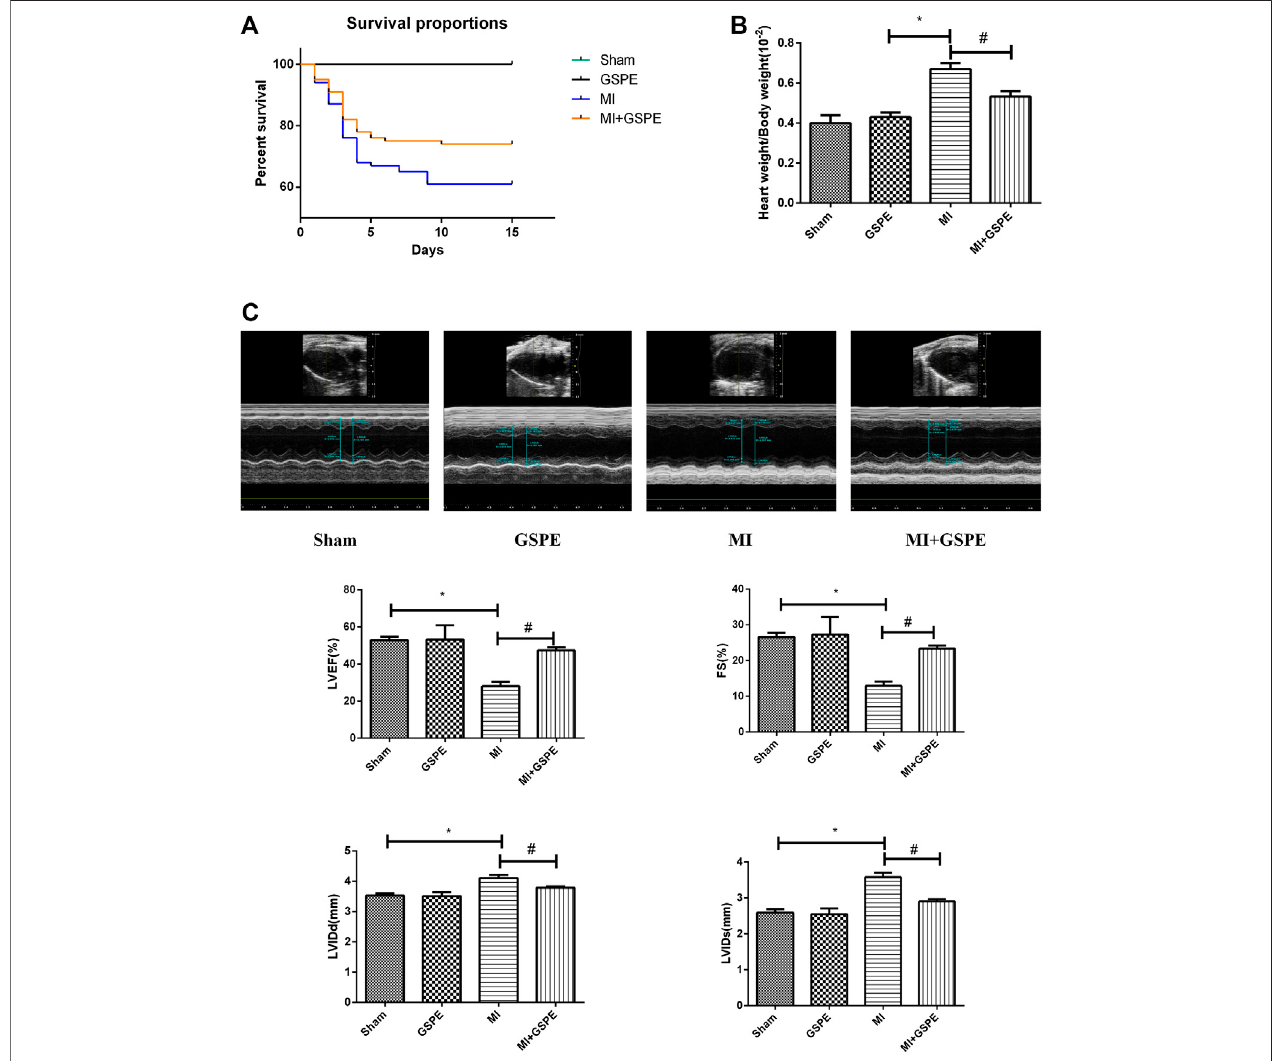
FIGURE 1 | GSPE improved the survival rate and cardiac function of MI mice. (A) The survival rate of mice in the GEPE-treated group compared with the MI group (log-rank: p < 0.01). (n (cid:2) 3 per group) (B) The heart/body weight ration of mice in different groups. (C) Representative M-mode echocardiographic images in short axis fromeachgroup,therelativeindicatorsincludedareLVEF(%),FS(%),LVIDd(mm).Dataanalyzedaremean ± SD.*Signi fi cantdifferencecomparedwiththecontrolgroup, p < 0.05; #signi fi cance compared with the MI group, p < 0.05. n (cid:2) 3 per group.